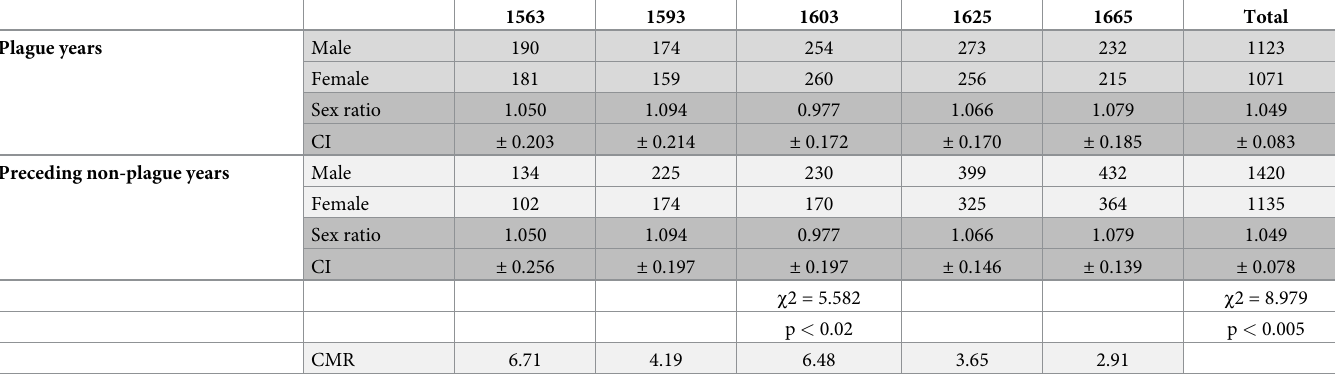
Table 5. A comparison between the frequency of burials of male and female children for five plague years and the preceding non-plague years in selected parishes. The combined totals for plague and non-plague years are also